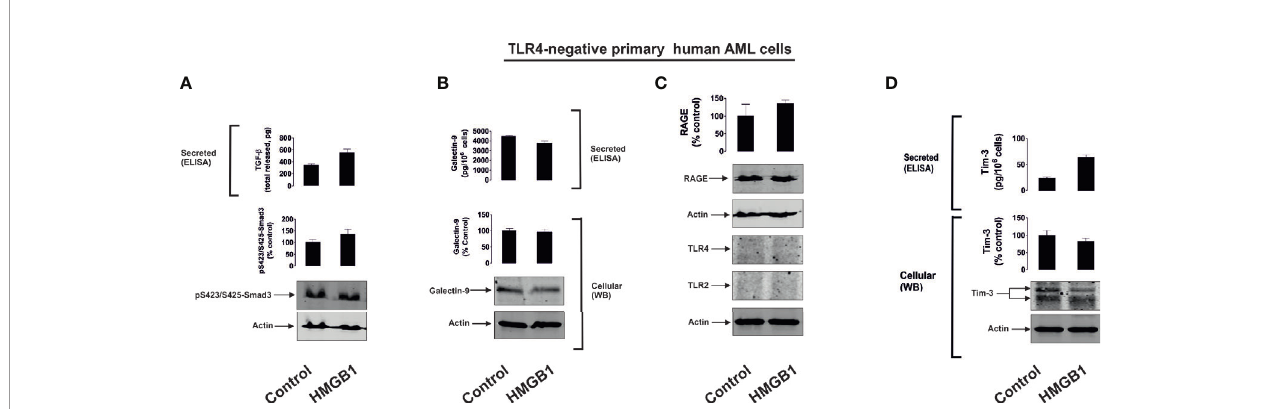
FIGURE 2 | HMGB1 does not induce TGF- b secretion and galectin-9 expression in primary human AML cells lacking expressions of TLRs 2 and 4. Primary human AML cells lacking expression of TLRs 2 and 4 were exposed for 16 h to 2.5 µg/ml HMGB1 and TGF- b secretion and Smad3 activating phosphorylation (A) , galectin- 9 expression and secretion (B) , expression of TLRs 2 and 4 as well as RAGE proteins (C) and Tim-3 protein expression and secretion (D) were analysed. Images are from one experiment representative of 4 which gave similar results. Quantitative data are shown as mean values ± SEM from four independent experiments.